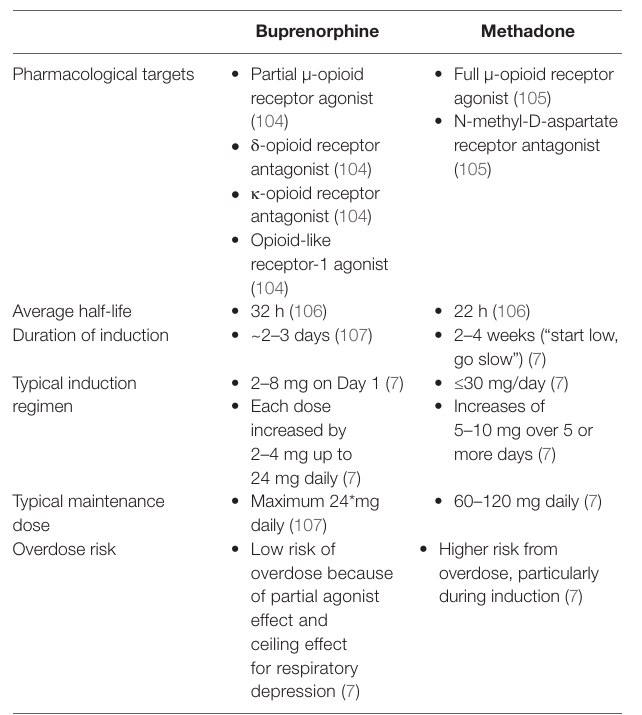
TABLE 2 | Comparison of oral/sublingual buprenorphine and methadone in OUD maintenance treatment.